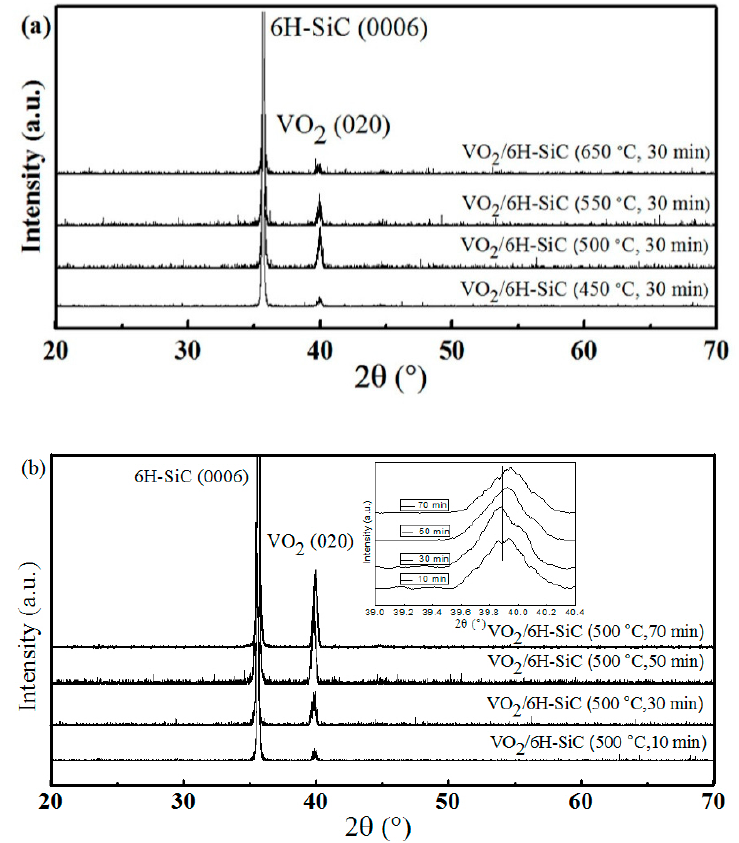
Figure 1. ( a ) and ( b ) were X-ray diffractometer (XRD) patterns of the samples of S 1 and S 2 group, respectively. Inset: enlarged view of the corresponding (020) diffraction peak of the VO 2 /6H-SiC films at different deposition times.